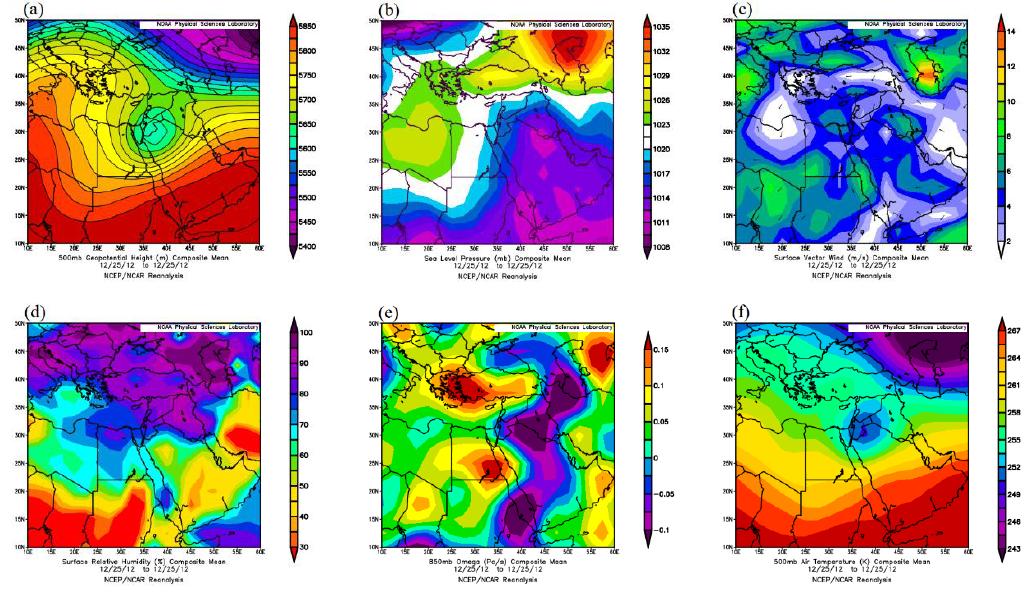
Figure 4: The weather chart for 25 December 2012, (a) 500 mb geopotential height (m), (b) sea level pressure (mb), (c) surface wind (m/s), (d) surface relative humidity (%), (e) 850 mb omega (pa/s), and (f) temperature (k) at 500 mb.